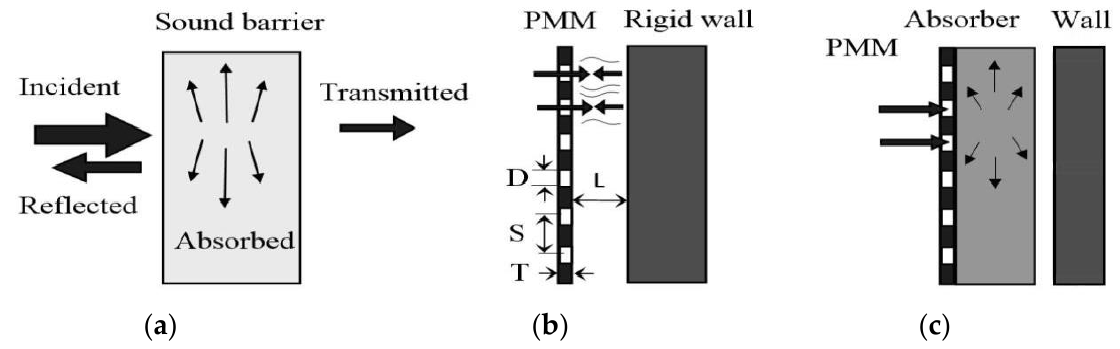
Figure 18. General schemes of sound absorption PMM: sound transformation scheme ( a ), absorption scheme using a protective perforated wall ( b ). also, with the addition of soundproofing material(s) ( c ) (D—diameter of holes, S—distance between hole centers, T—screen thickness, L—distance from screen to object surface).